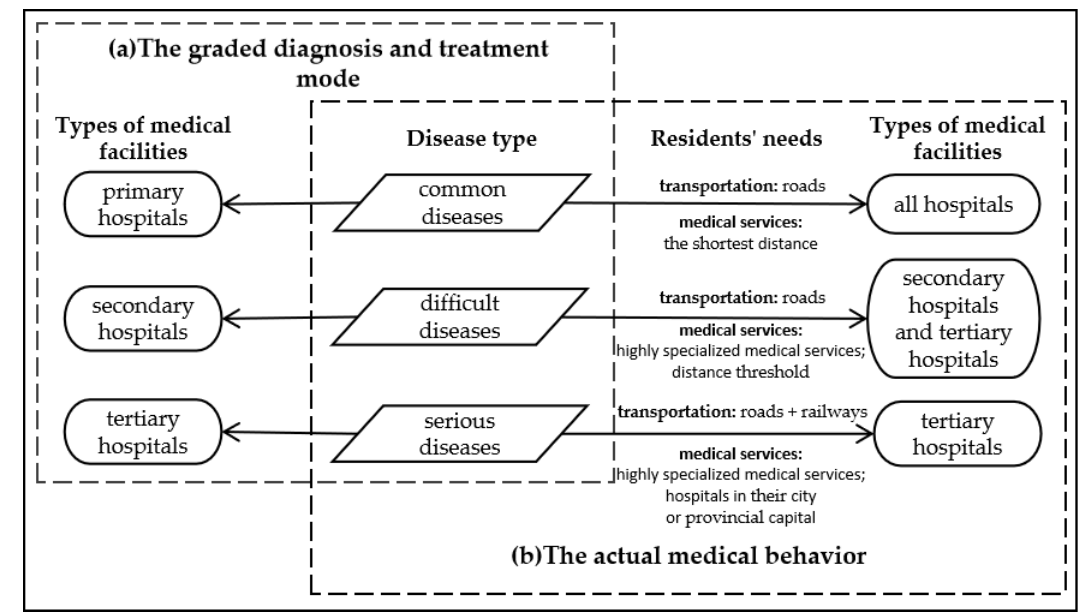
Figure 3. Concept map of ( a ) the graded diagnosis and treatment mode; ( b ) the actual medical behavior.